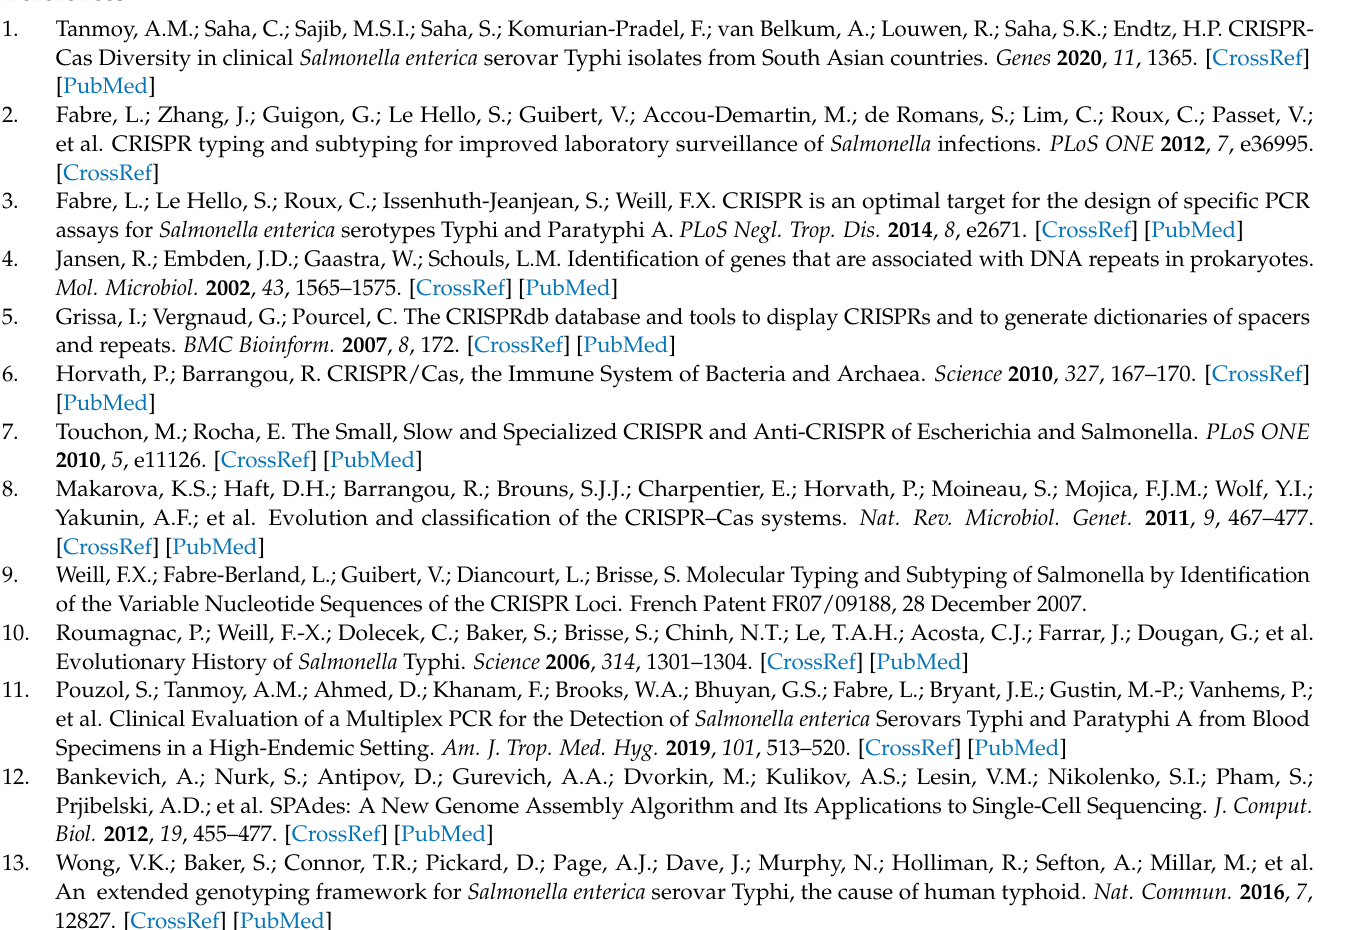
studied. Table S2: Discrepancies between genotype data from the study by Tanmoy et al. [1] and our study. Table S3: Strains described in Tanmoy et al. [14] and their different accession codes. Table S4: Correspondence between the spacer and DR sequences described by Tanmoy et al. [1] and those from Fabre et al. [2], and prevalence of these sequences among the 1059 S. enterica serovar Typhi genomes studied.Table S5: Correspondence between the “Group-A” CRISPR locus patterns from Tanmoy et al. [1] and our CRISPR